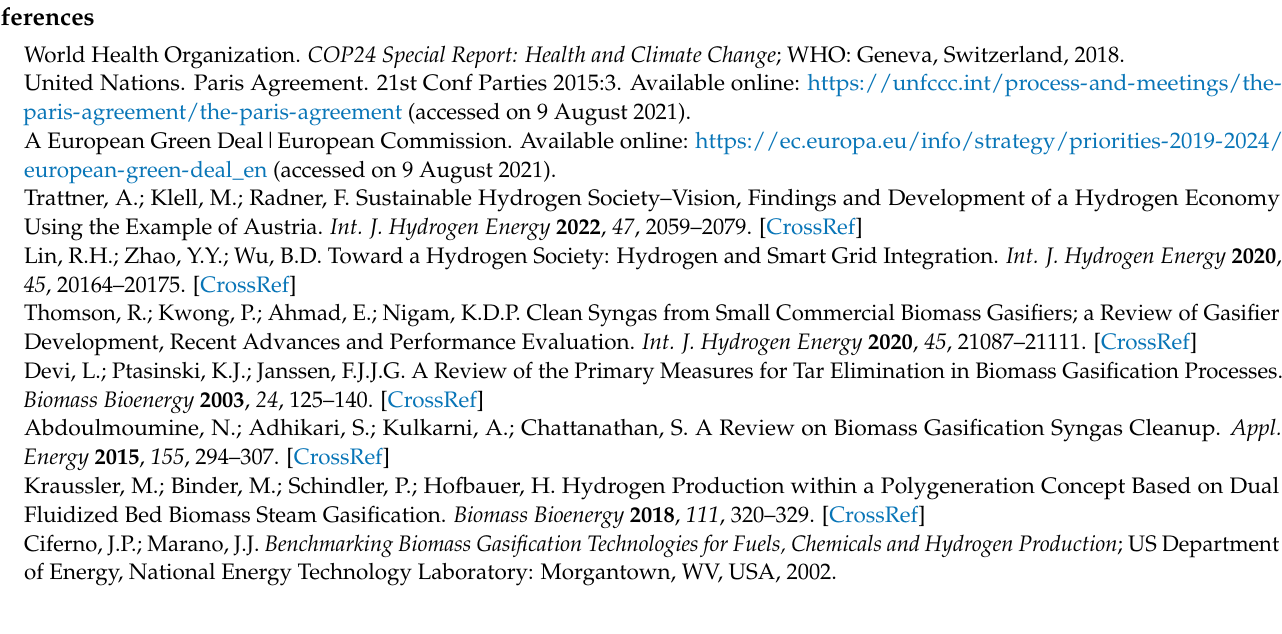
Figure A7. Temperature and gas composition ( a ) and ammonia content ( b ) during test 8 .